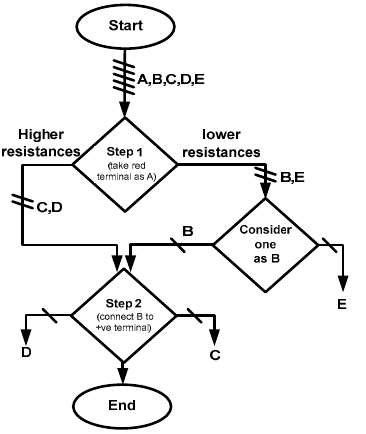
Figure 8. Flow chart of phases sequence identification.